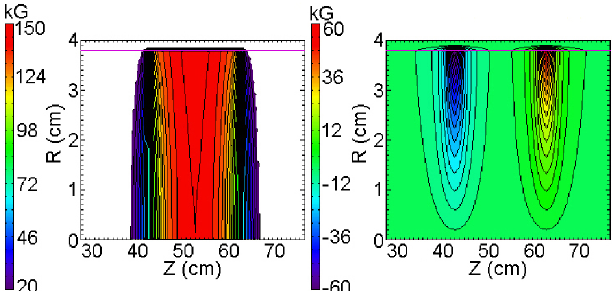
g r FIG. 25. (Color) f r; z g isocontours of axial B (right) field magnitudes from a 150 kG solenoid of length l sol (cid:4) 20 cm and radius r sol (cid:4) 3 : 8 cm , centered at z (cid:4) (cid:8) 52 : 6 cm .